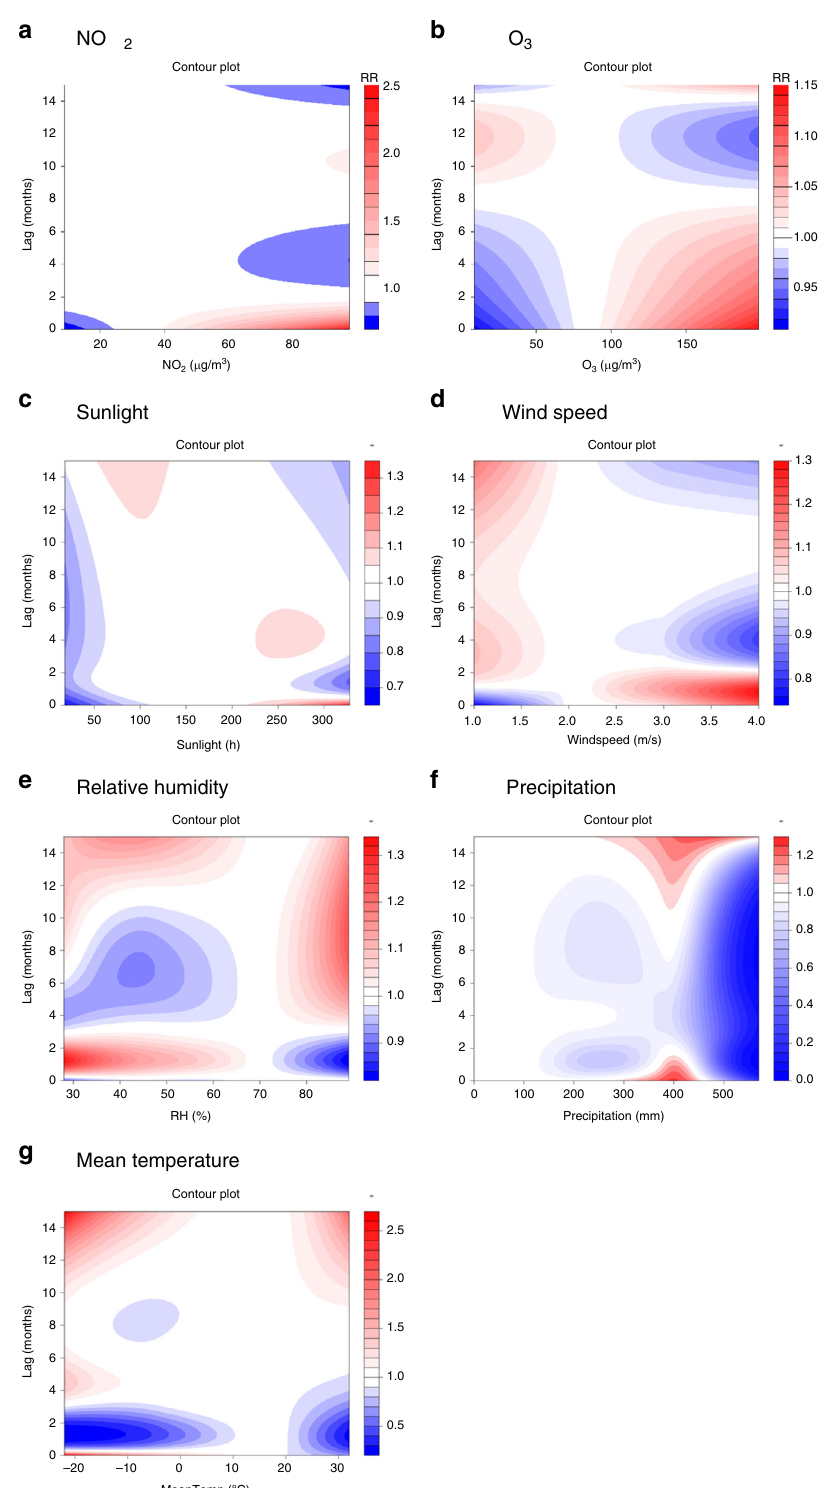
Fig. 6 Contour plots of the exposure – response relationship for the association between scarlet fever incidence and air pollutants or meteorological conditions in the multiple-variable model from 2013 to 2018. In addition to the adjusted air pollutants and meteorological conditions, the other adjusted variables in the model are temporal trend, the indicator variable of summer and winter breaks, and quantile groups both for average incidences and for incidence in the previous month. a NO 2 b O 3 c Sunlight d Wind speed e Relative humidity f Precipitation g Mean temperature. The reference level is set as the median value of the corresponding variable. The Y -axis is the lag month ranging from 0 to 15. The X -axis is the range of the observed values of each variable. The color gradient represents the relative risk (RR). The red color gradient represents higher strength of RR, above 1, and the blue gradient represents lower strength of RR, below 1. The white color represents no difference, at RR = 1. Source data are provided as a Source Data fi